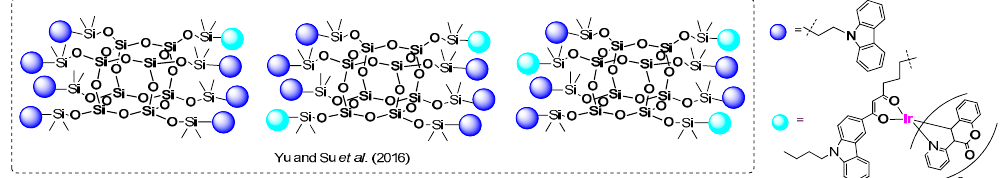
Figure 35. The spherosilicate-based complexes with one, two and three Ir complexes obtained by hydrosilylation.